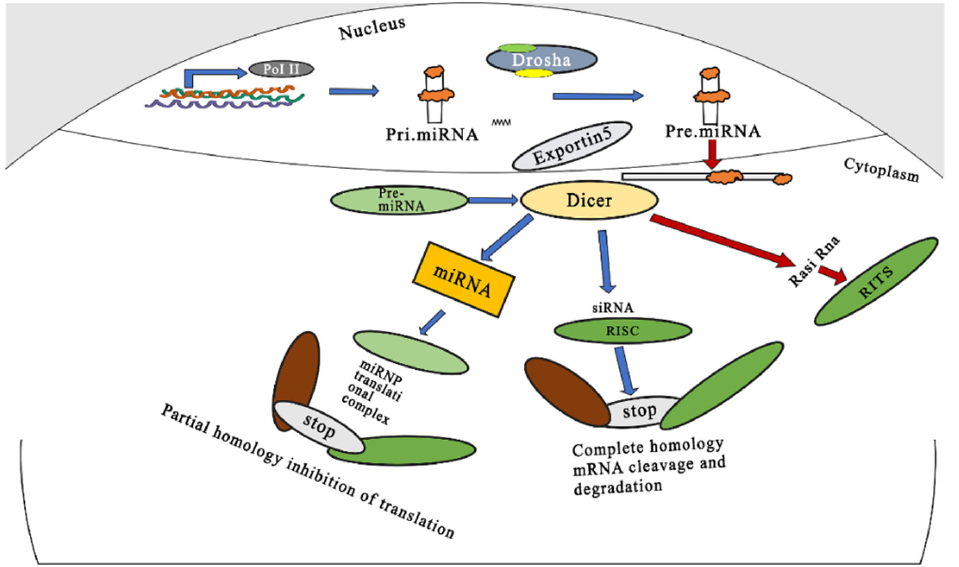
Figure 1. Schematic representation of mechanism of gene silencing by miRNAs and siRNAs.